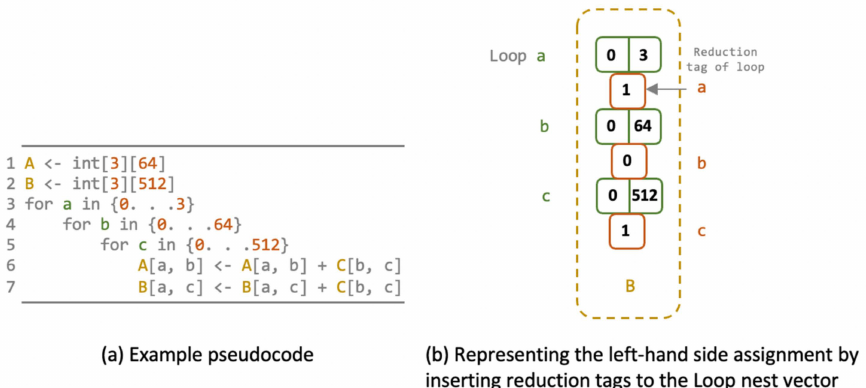
Figure 8. Add tag and merge loop